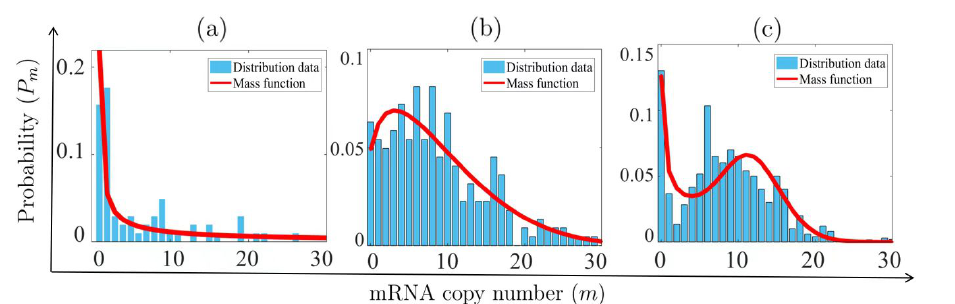
Figure 1. Three modes of mRNA distribution. ( a ) Decaying distribution for which the mass function P m gradually decreases in mRNA copy number m = 0,1, · · · . ( b ) Unimodal distribution that P m has a unique peak at m > 0. ( c ) Bimodal distribution that P m takes two peaks: one at m = 0 and the other at m > 0. mRNA distribution data (blue bars) and their fits by P m (red lines) of the two-state model (2) are shown for the ( a ) tetO promoter in CHO cells[10], ( b ) Mbln2 gene in mouse fibroblast cells[4], and ( c ) promoter P lac/ara in E.coli